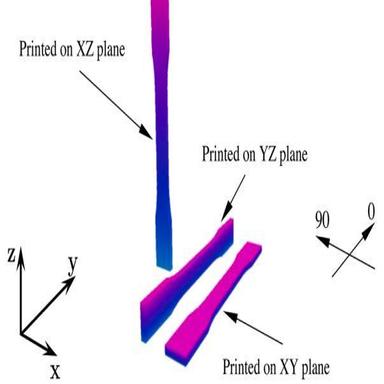
Printing orientations of tensile test specimens.